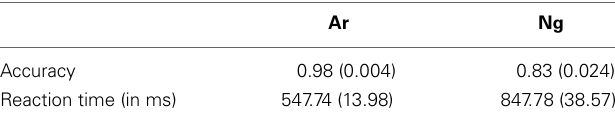
Figures in parentheses indicate standard error of mean (s.e.m).